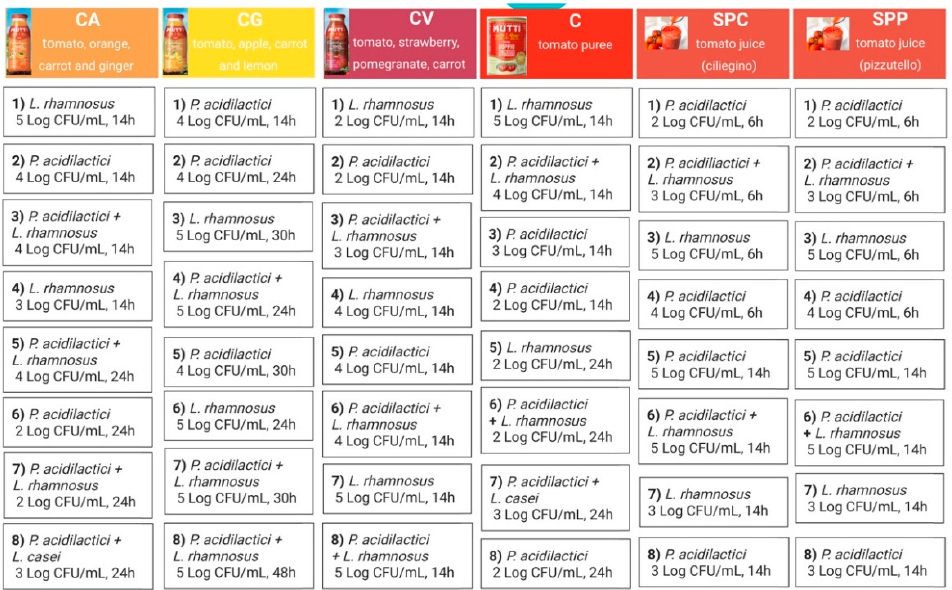
Figure 2. Combination of strains and co-cultures selected for each matrix, inoculum size (Log CFU / mL) and fermentation time. These combinations were used both for pasteurized (TT) and refrigerated (NTT) samples.